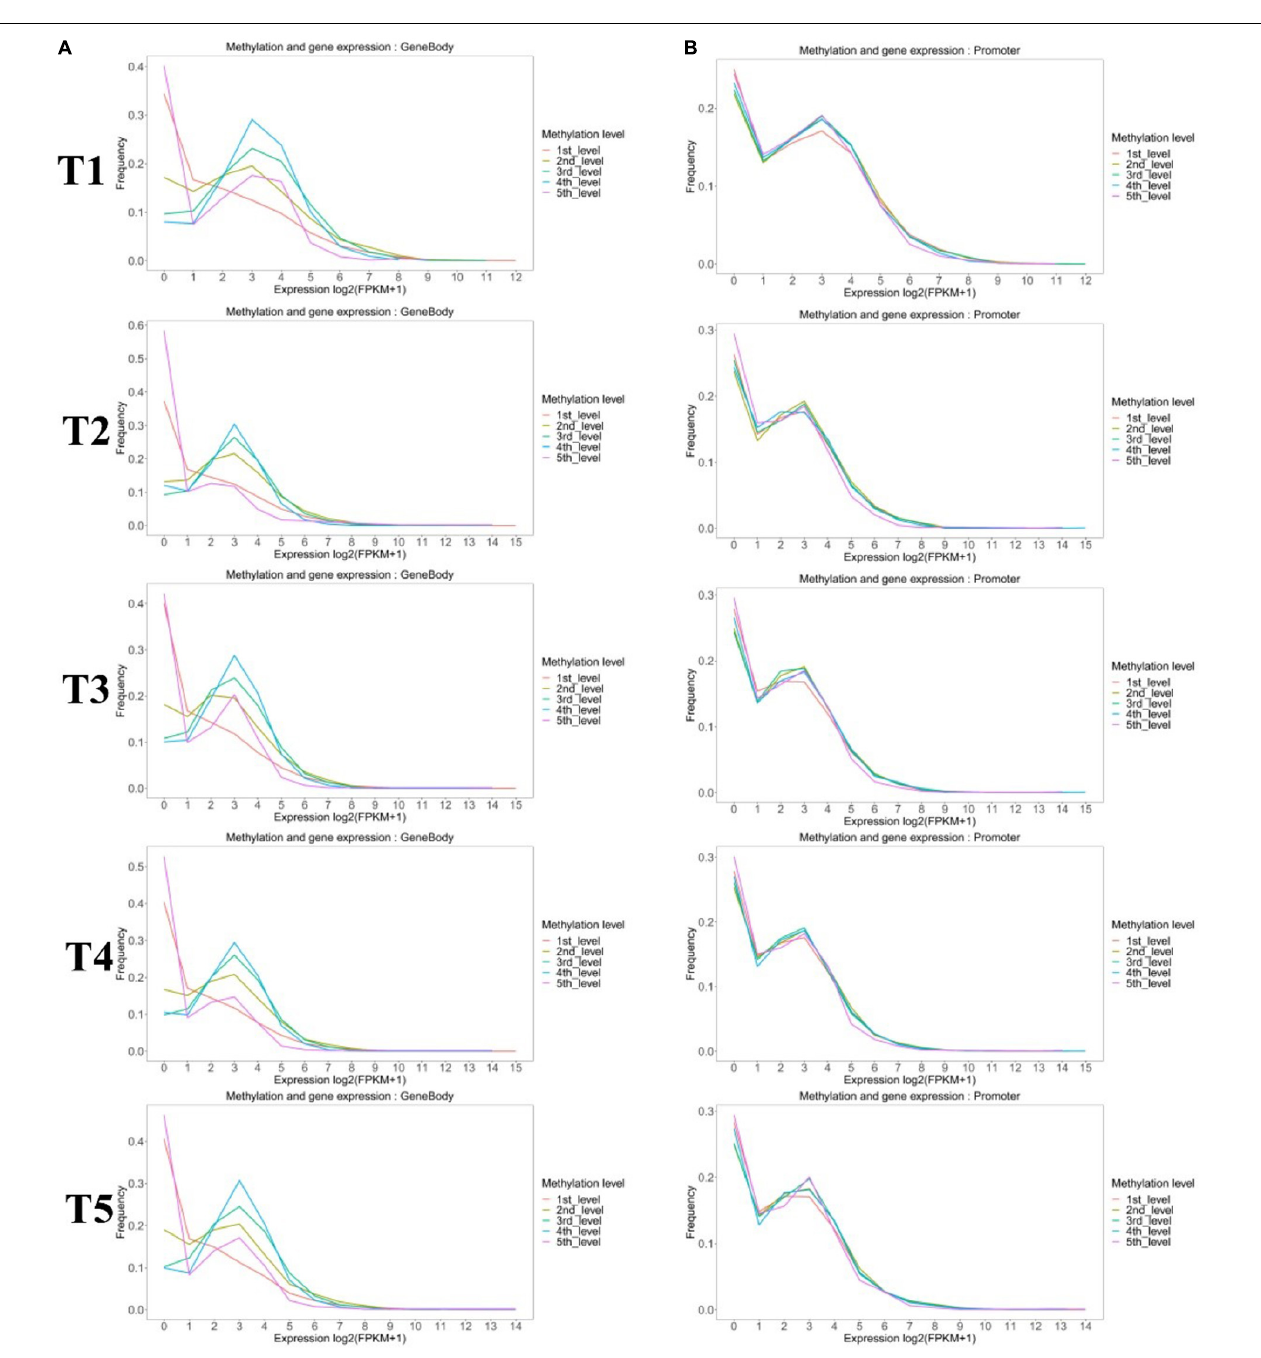
FIGURE 6 | Comparison of the expression profiles of methylated and unmethylated genes. Methylated genes were further divided into quintiles based on (A) gene-body and (B) promoter methylation levels as follows: first: methylation level < 20%; second: 20% < methylation level < 40%; third: 40% < methylation level < 60%; fourth: 60% < methylation level < 80%; and fifth: methylation level >